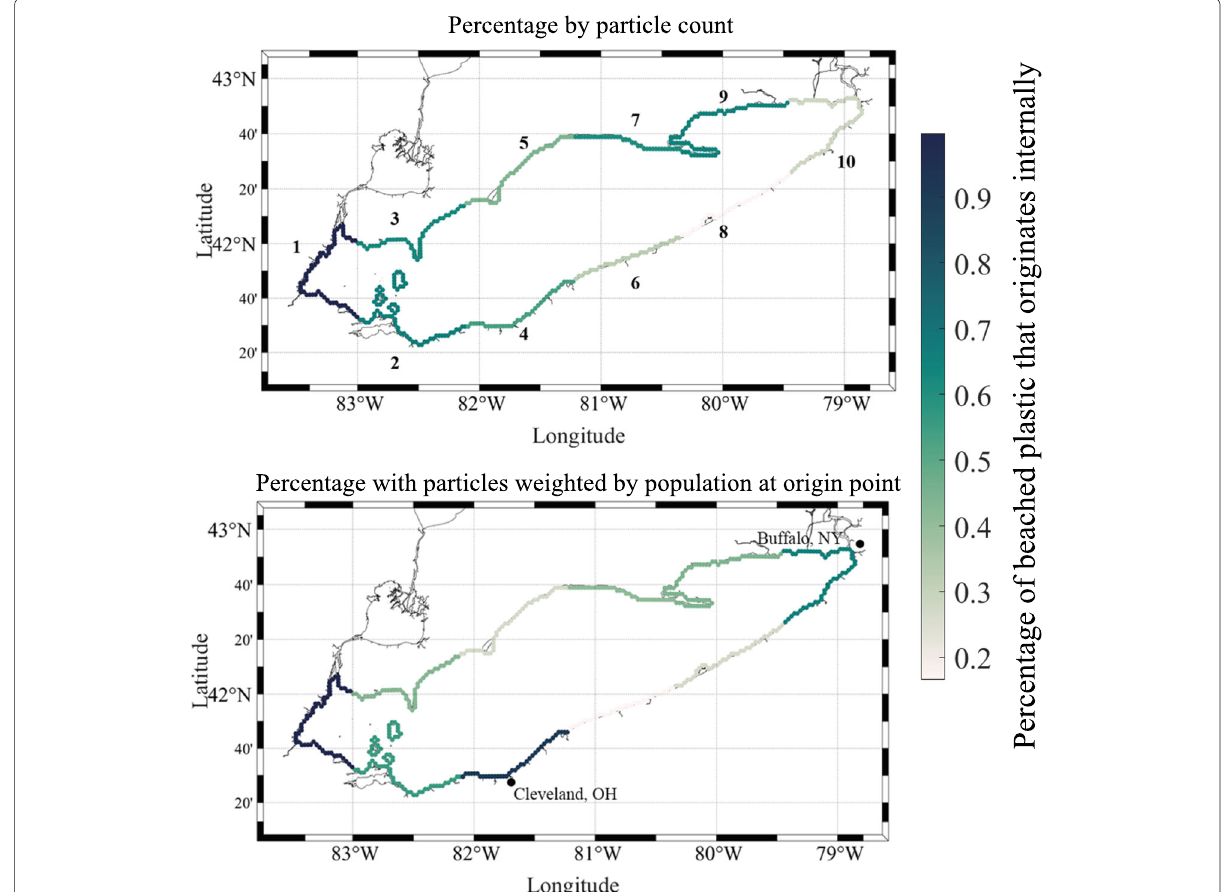
Fig. 6 Percentage of beached plastic in a region that originated internally. Top: percentage by particle count, bottom: percentage with particles weighted by population at origin point. Numbers in top figure correspond to region